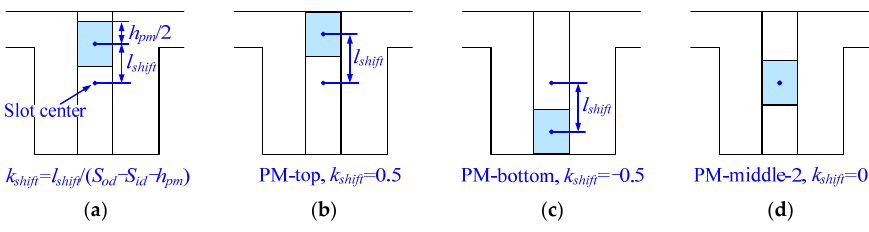
Figure 10. Illustration of the PM shifting in the PM ‐ middle ‐ 2 machine. ( a ) Definition of shifting coefficient k shift ; ( b ) Equivalent to PM ‐ top topology when k shift = 0.5; ( c ) Equivalent to PM ‐ bottom topology when k shift = − 0.5; ( d ) PM ‐ middle ‐ 2 topology when k shift = 0.